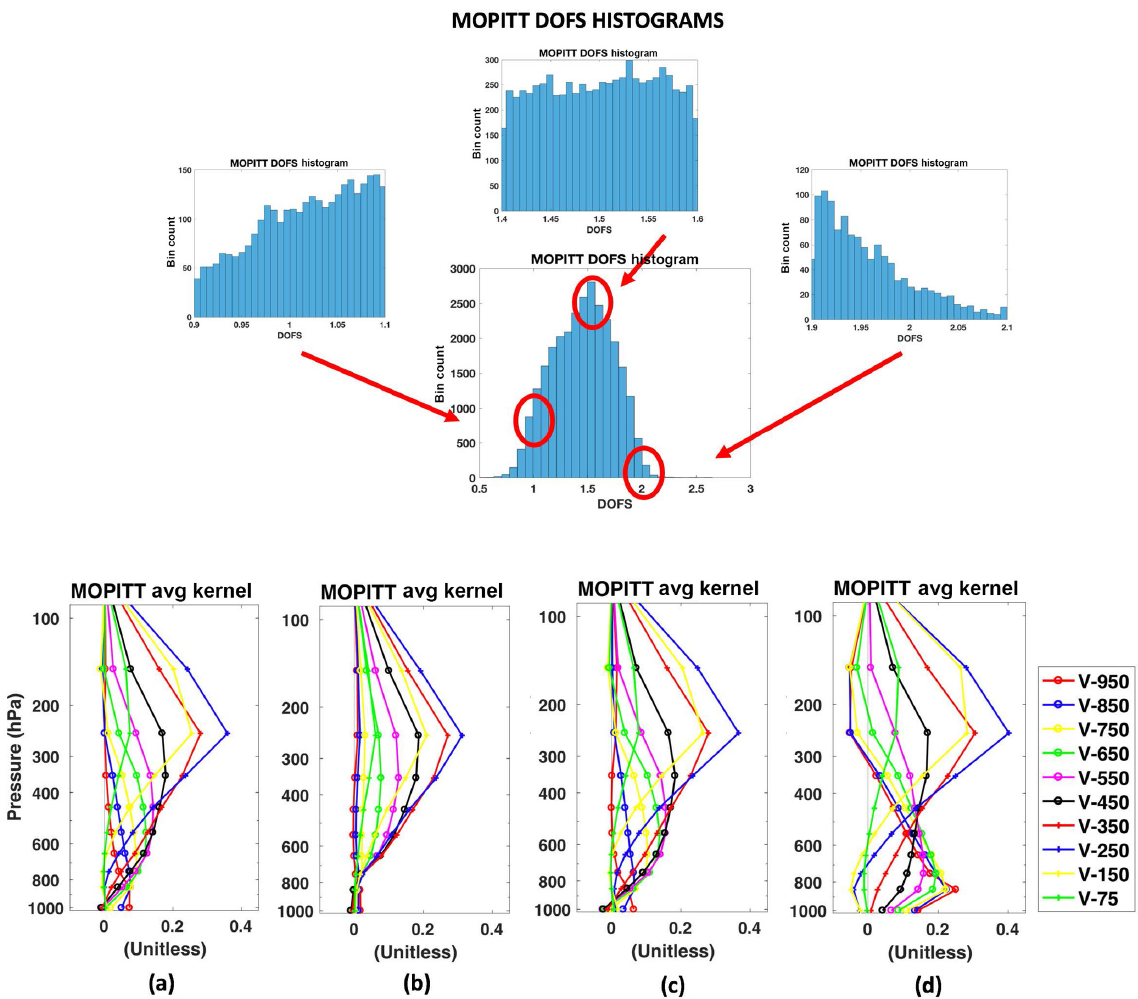
Figure 3. Histogram of MOPITT CO degrees of freedom of signal (DOFS) with blow-up histograms for selected DOFS ranges in the upper panels. The lower panels show composite MOPITT CO averaging kernel profiles for (a) all DOFS, (b) (0 . 9 ≤ DOFS ≤ 1 . 1), (c) (1 . 4 ≤ DOFS ≤ 1.6), and (d) (1 . 9 ≤ DOFS ≤ 2 . 1). The averaging kernel identifiers are V-xxx where xxx is the approximate pressure level midpoint in hPa for the associated averaging kernel